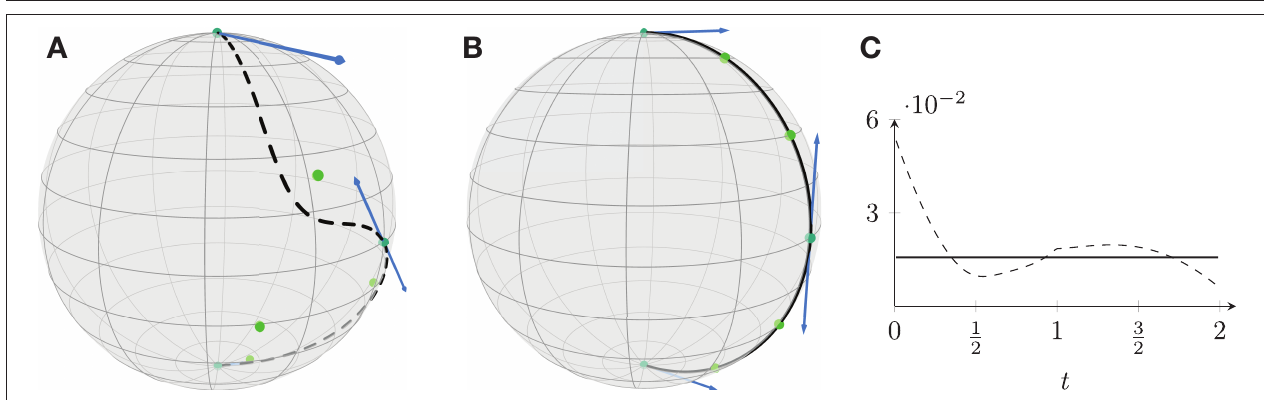
FIGURE 8 | The initial curve (dashed, A ) results in a geodesic (solid, B ) when minimizing the discrete acceleration. This can also be seen on the first order differences (C) .